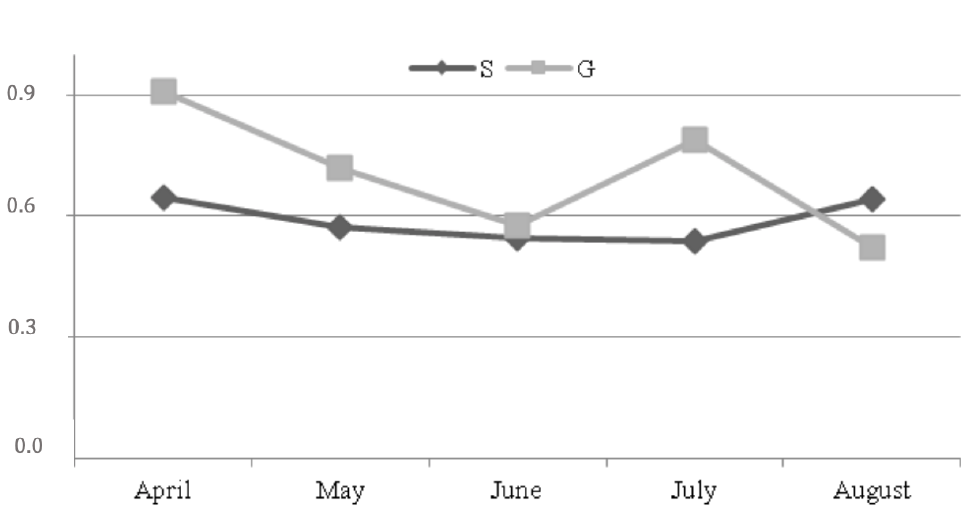
Figure 2. SCD expression (AU: Arbitrary unity) along the trial (*SEM = 0.362). * standard error of mean.